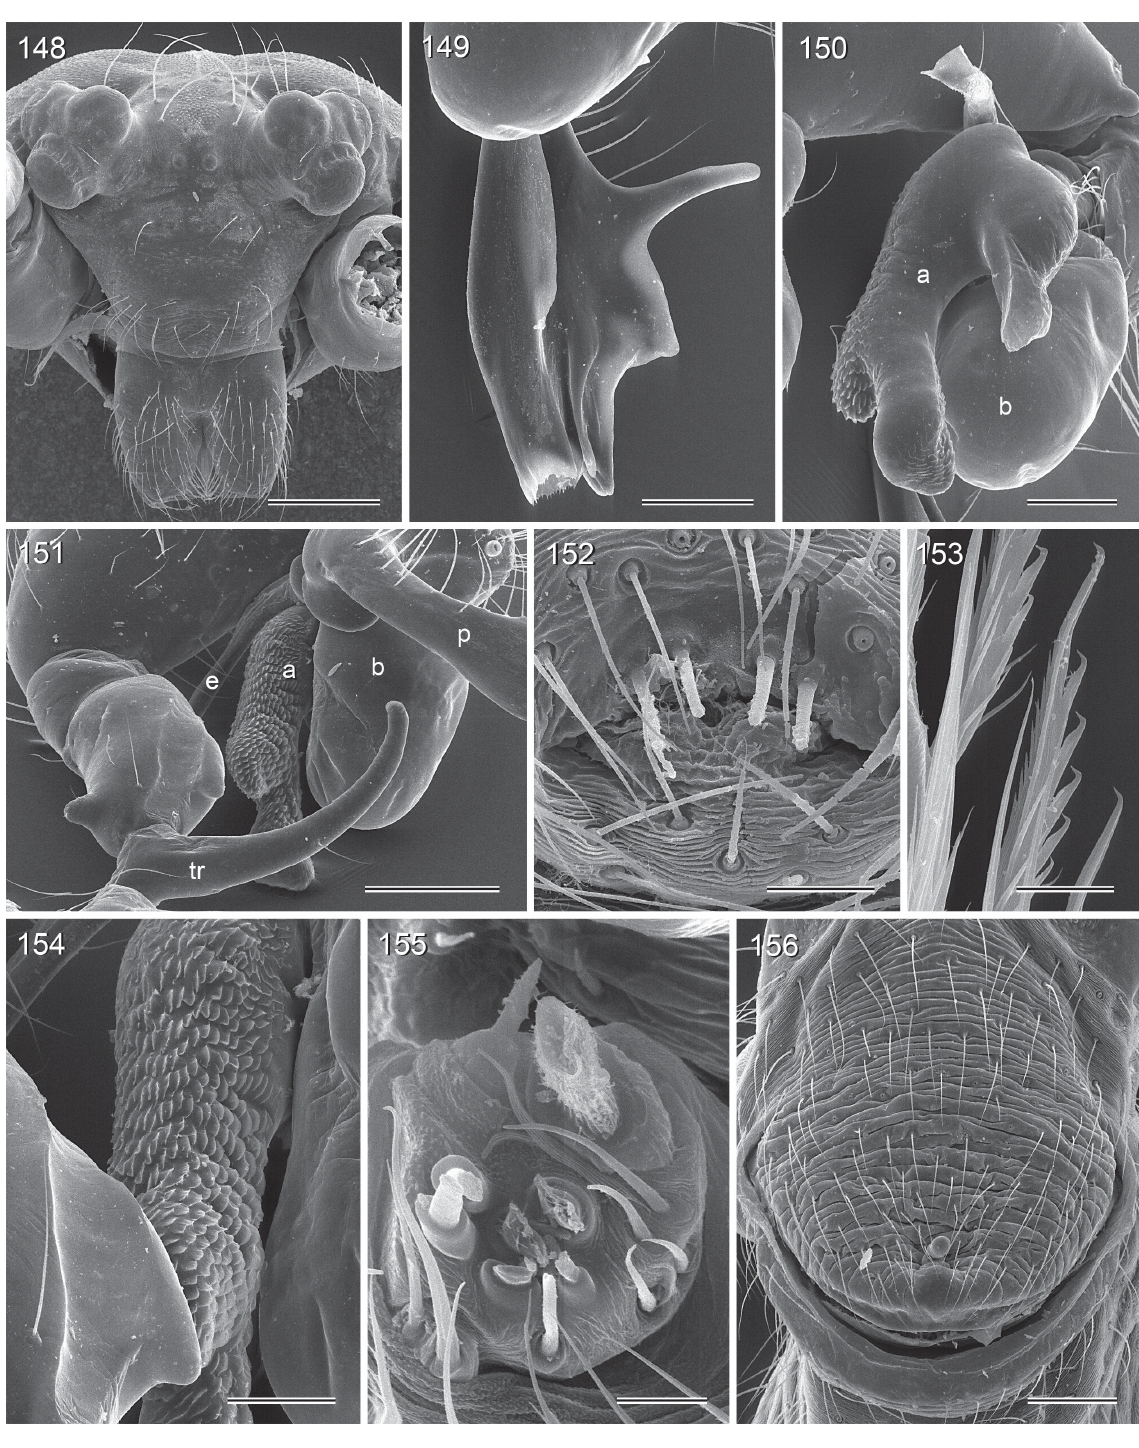
Figs 148–156. Pholcus domingo Huber sp. nov., SeM micrographs (ZFMK, Ar 15720–21). 148 . Male prosoma, frontal view. 149 . Tip of left procursus, prolateral view. 150 . Left bulb and appendix, prolatero- distal view. 151 . right male palp, retrolatero-distal view. 152 . Male gonopore. 153 . Comb-hairs on male tarsus 4. 154 . right appendix, retrolateral view. 155 . Female ALS. 156 . epigynum, ventral view. Scale bars: 148, 151 = 200 µm; 149–150, 156 = 100 µm; 152 = 30 µm; 153, 155 = 10 µm; 154 = 60